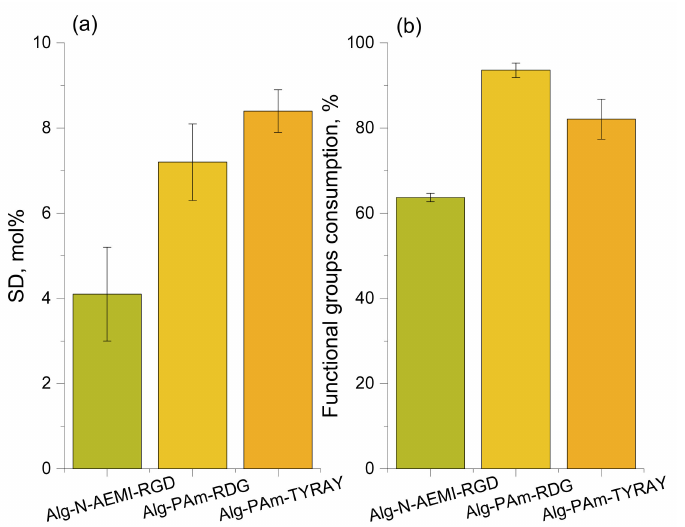
Figure 5. ( a ) The substitution degree for different click reactions; ( b ) the consumption of functional groups on alginate for different click reactions. All values are reported as mean with the standard deviation ( n =